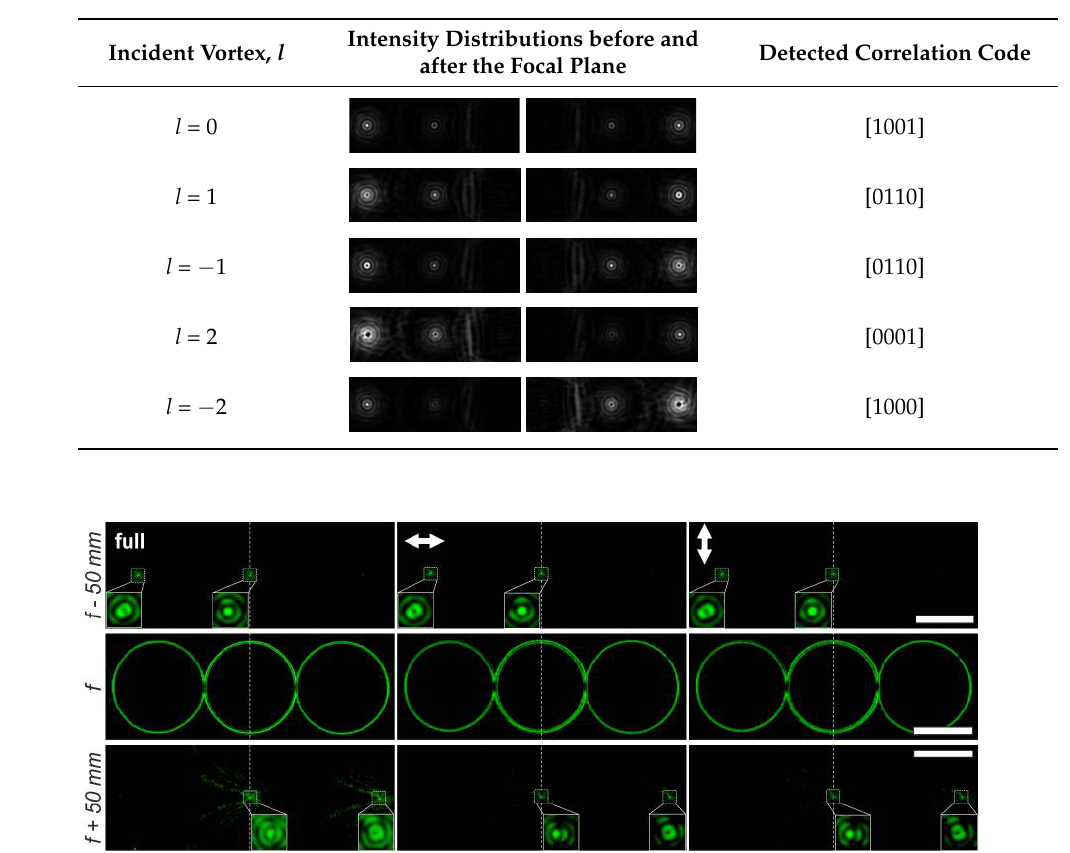
Figure 5. Experimentally obtained transverse component distributions of the focused circularly polarized laser beam passed through the fabricated DOE. The intensity distributions were formed in the focal plane of the lens L 4 . The white arrow shows the position of the axis of the polarizer-analyzer. The scale bar is 1 mm.